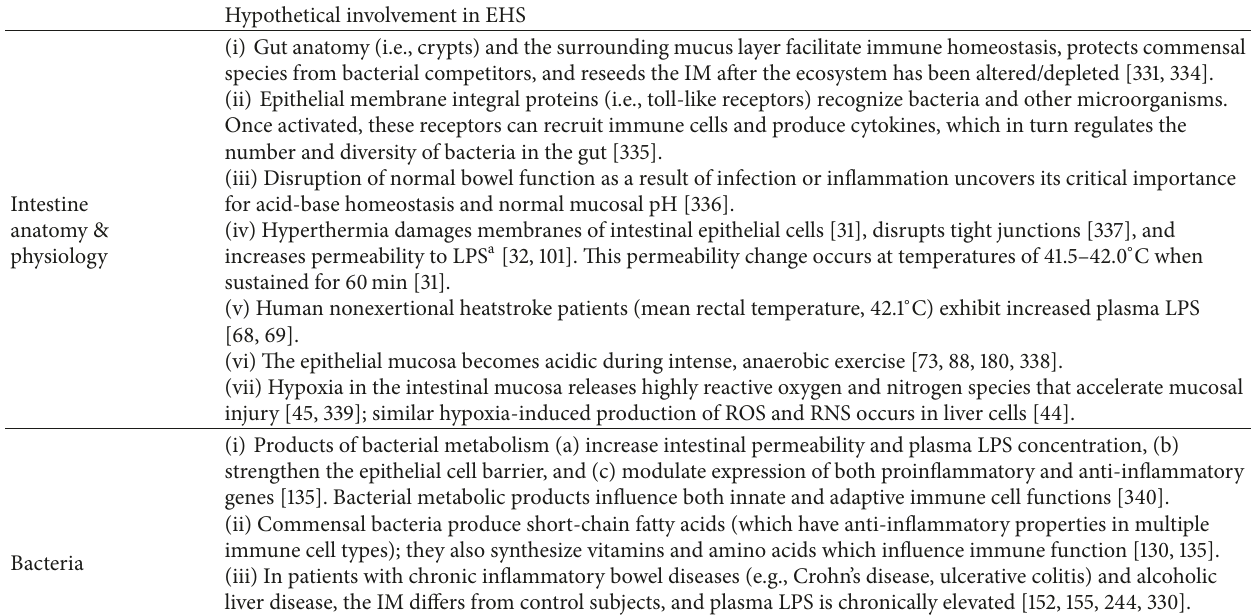
Table 5: Potential interactions among intestine anatomy/physiology, bacteria, immune function, diet, exercise stress, and the host genome as predisposing factors for exertional heatstroke